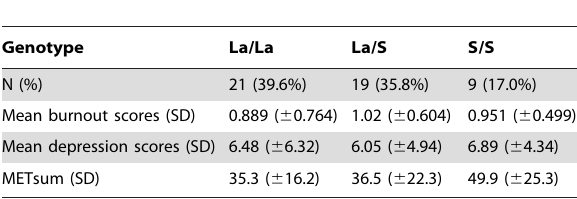
Table 2. Distribution of the 5-HTTLPR genotype.